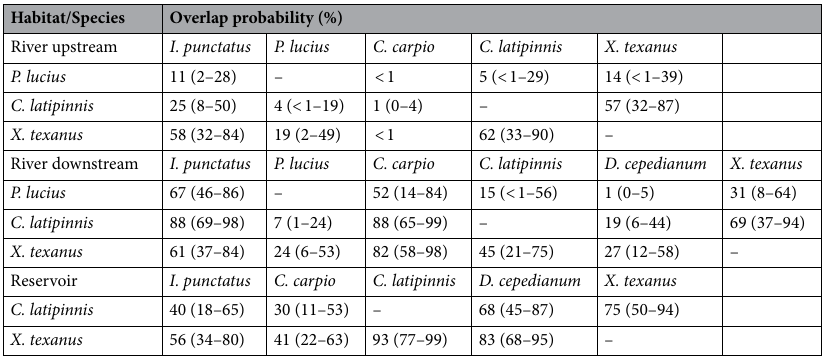
Table 3. Mean overlap probabilities (95% credible intervals) from posterior distributions of the probability of species in rows overlapping onto the 95% isotopic niche of species in columns for each habitat sampled in the San Juan River and Lake Powell reservoir. Estimates are based on 10,000 Monte Carlo iterations. Full species names are provided in Table